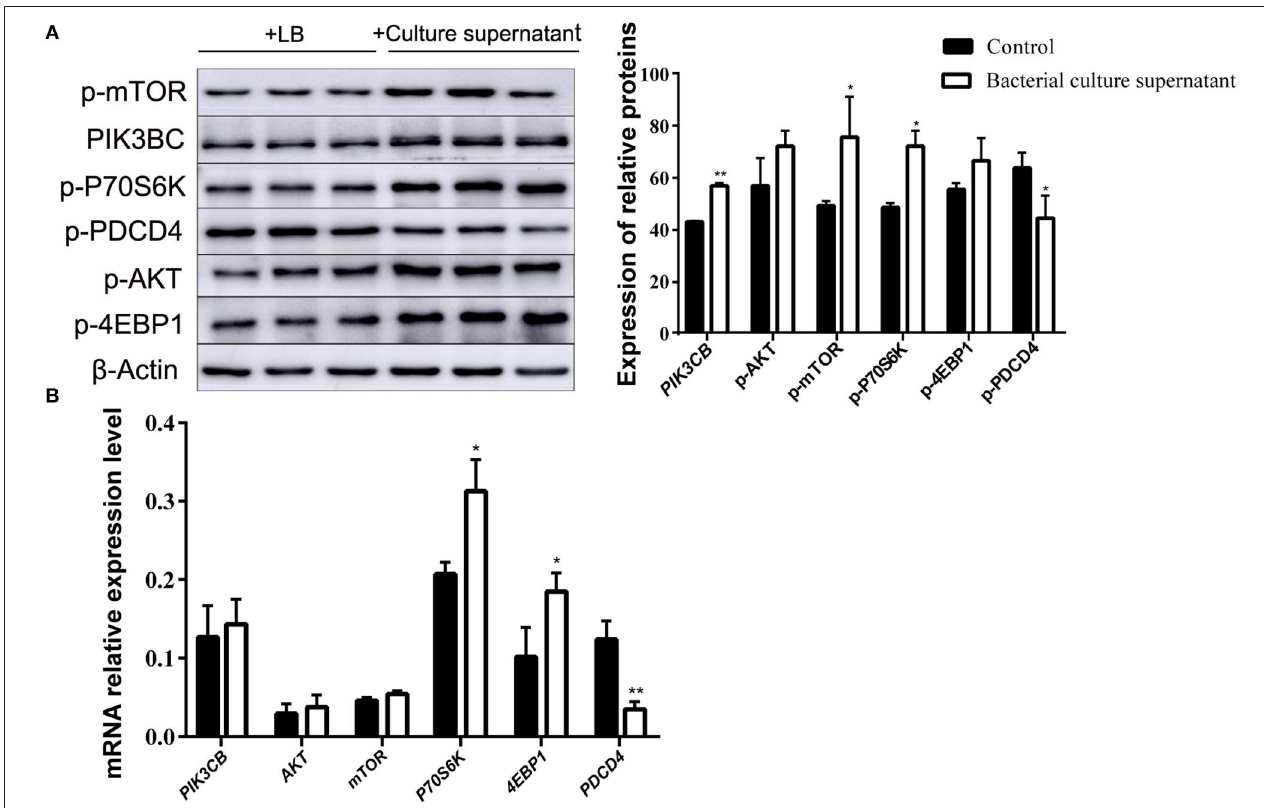
FIGURE 9 | Expression of proteins (A) and genes (B) in the rumen explants with supernatant of inactivated bacteria ( n = 9). One-way ANOVA in SPSS 22.0 software was used to analyse the data, presented as mean ± sd. The ratio of all gene expression levels compared to the housekeeping gene β -actin was obtained as the relative expression of the gene. *Indicates significant difference from control group within the same group ( p < 0.05). **Indicates highly significant difference ( P <